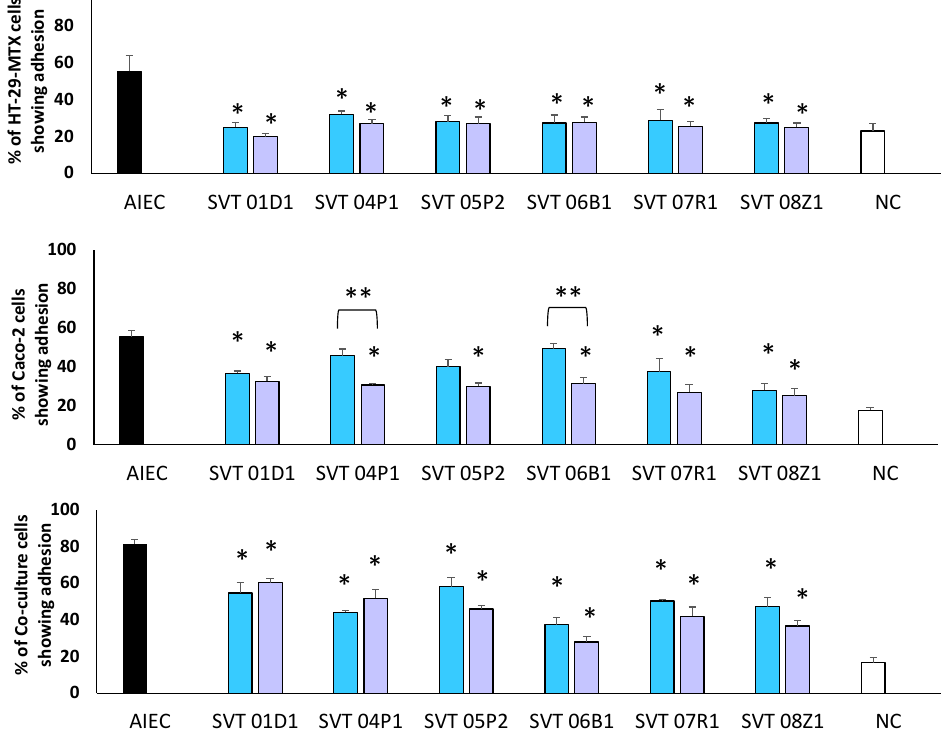
*** Figure 1. Colonization of HT-29-MTX, Caco-2 and co-culture of Caco-2/HT-29-MTX cells by AIEC Figure 1. Colonization of HT-29-MTX, Caco-2 and co-culture of Caco-2/HT-29-MTX cells by AIEC Figure 2. The number of AIEC cells adhering per cell on HT-29-MTX, Caco-2 and co-culture of Caco- Figure 1. Colonization of HT-29-MTX, Caco-2 and co-culture of Caco-2/HT-29-MTX cells by AIEC Figure 2. The number of AIEC cells adhering per cell on HT-29-MTX, Caco-2 and co-culture of Caco- Figure 2. The number of AIEC cells adhering per cell on HT-29-MTX, Caco-2 and co-culture of Caco- alone , AIEC when co-inoculated with the LBPs , AIEC in the presence of pre-inoculated LBPs alone 2/HT-29-MTX cells. AIEC alone , AIEC when co-inoculated with the LBPs , AIEC when cells alone , AIEC when co-inoculated with the LBPs , AIEC in the presence of pre-inoculated LBPs 2/HT-29-MTX cells. AIEC alone , AIEC when co-inoculated with the LBPs , AIEC when cells 2/HT-29-MTX cells. AIEC alone , AIEC when co-inoculated with the LBPs , AIEC when cells and negative control [NC] . * Significant differences between the percentages of cells showing were pre-inoculated with LBPs and negative control [NC] . Significant differences (*) were and negative control [NC] . * Significant differences between the percentages of cells showing were pre-inoculated with LBPs and negative control [NC] . Significant differences (*) were were pre-inoculated with LBPs and negative control [NC] . Significant differences (*) were . * Significant differences between the percentages of cells showing adhesion with AIEC before addition of LBPs strains in co-inoculation or pre-inoculation experi- observed before and after the addition of LBP strains (co-inoculation or pre-inoculation); p <0.0001 observed before and after the addition of LBP strains (co-inoculation or pre-inoculation); p <0.0001 observed before and after the addition of LBP strains (co-inoculation or pre-inoculation); p <0.0001 adhesion with AIEC before addition of LBPs strains in co-inoculation or pre-inoculation experiments; ments; p ≤ 0.0001 (HT-29-MTX), p ≤ 0.0001 (Caco-2), p ≤ 0.0001 (Co-culture). ** Significant difference (HT-29-MTX), p < 0.0001 (Caco-2), p < 0.0001 (Co-culture). ** Significant difference between co-inoc- (HT-29-MTX), p < 0.0001 (Caco-2), p < 0.0001 (Co-culture). ** Significant difference between co-inoc- (HT-29-MTX), p < 0.0001 (Caco-2), p < 0.0001 (Co-culture). ** Significant difference between co-inoc- p ≤ 0.0001 (HT-29-MTX), p ≤ 0.0001 (Caco-2), p ≤ 0.0001 (Co-culture). ** Significant difference between co-inoculation and pre-inoculation for SVT 06B1 ( p = 0.03) in Caco-2. ulation and pre-inoculation for SVT 05P2 ( p = 0.049) and SVT 06B1 ( p = 0.04) in Caco-2, and SVT ulation and pre-inoculation for SVT 05P2 ( p = 0.049) and SVT 06B1 ( p = 0.04) in Caco-2, and SVT ulation and pre-inoculation for SVT 05P2 ( p = 0.049) and SVT 06B1 ( p = 0.04) in Caco-2, and SVT between co-inoculation and pre-inoculation for SVT 06B1 ( p = 0.03) in 08Z1 ( p < 0.0001) in HT-29-MTX. 08Z1 ( p < 0.0001) in HT-29-MTX. 08Z1 ( p < 0.0001) in HT-29-MTX. The number of AIEC strains adhering to individual cells of all three cell cultures was Table 1. Overall, pre-inoculation resulted in a greater reduction in adhesion of AIEC Table 1. Overall, pre-inoculation resulted in a greater reduction in adhesion of AIEC